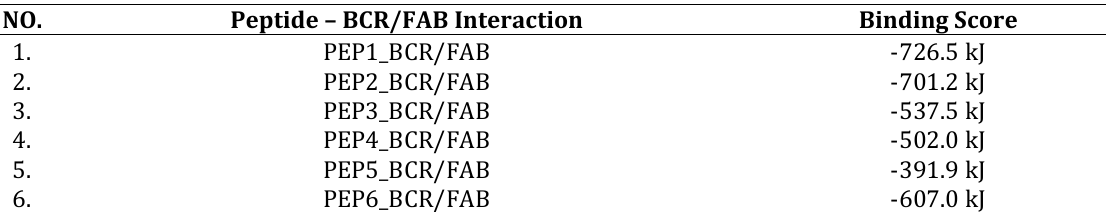
Table III. Binding affinity or binding score that were obtained from each of the molecular docking processes. The binding score had been sorted from the highest score (most negative) to the lowest score (least